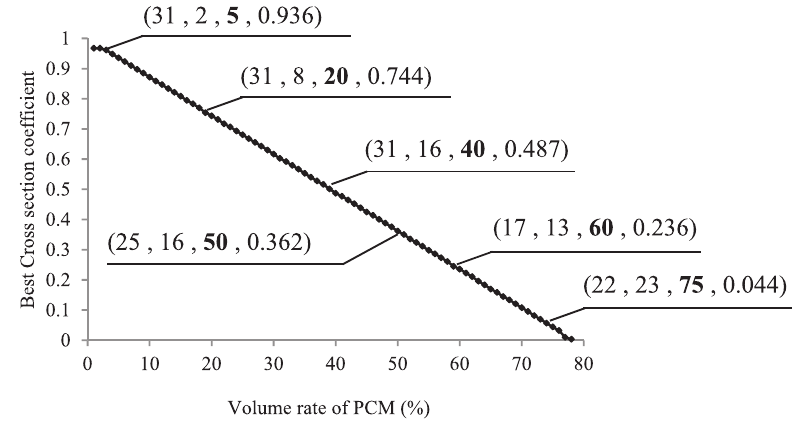
Fig. 12: Best cross section coefficient according to the PCM volume